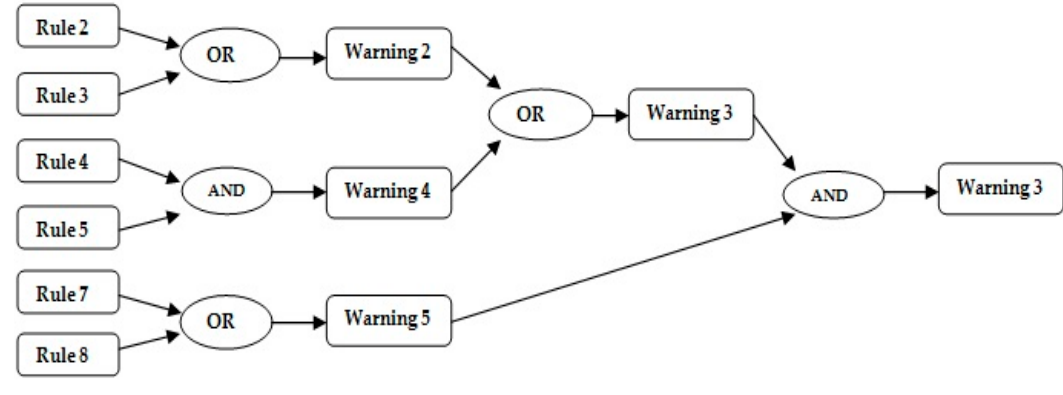
Figure 6. The working process of inference engine.